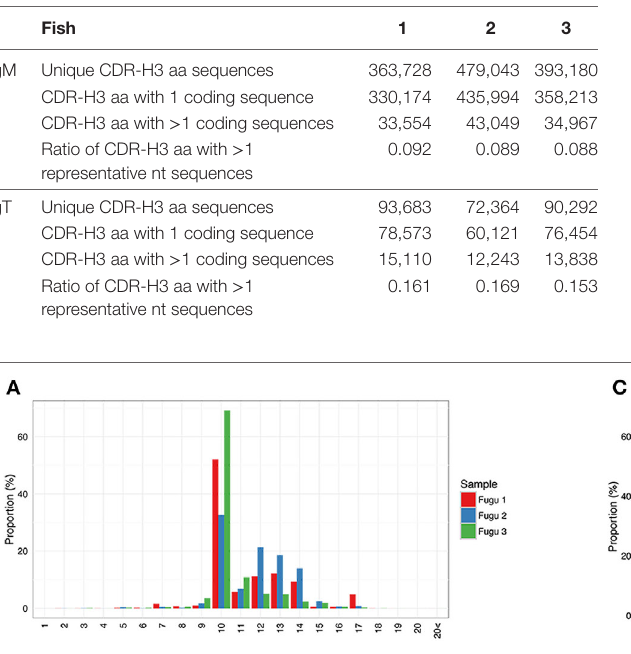
Table 2 | Summary of the convergent recombination of nucleotide (nt) sequences for heavy (H) chain complementarity-determining region 3 (CDR-H3) amino-acid (aa) sequences in IgM and